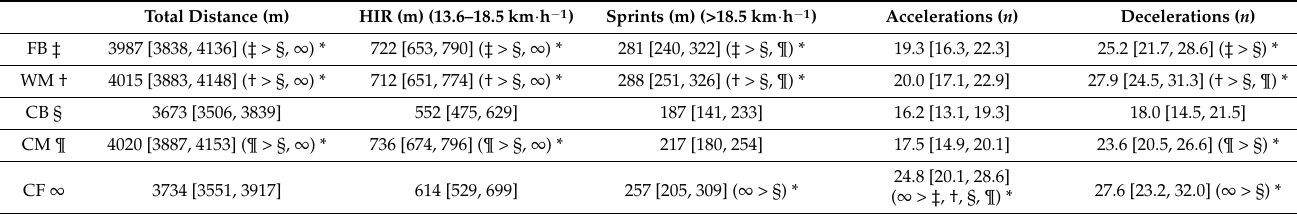
Table 2. Positional differences (mean ± 95% CI) in match running performance during one match half (35 min).